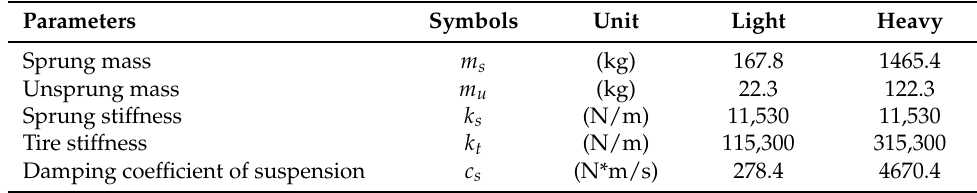
Table 3. Parameters for the quarter semi-active